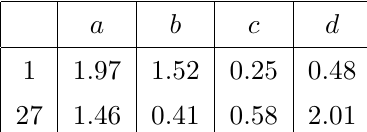
Figure 7 . Numerical results for sign [ G ( x )] ln j G ( x ) j for the singlet (blue) and 27 exchange (orange). The \heartbeat" at small x re(cid:13)ects the logarithmic divergence of ln j G ( x ) j where G ( x ) changes its sign for the (cid:12)rst time (similar divergences occur every oscillation but are not visible due to the (cid:12)nite resolution of the